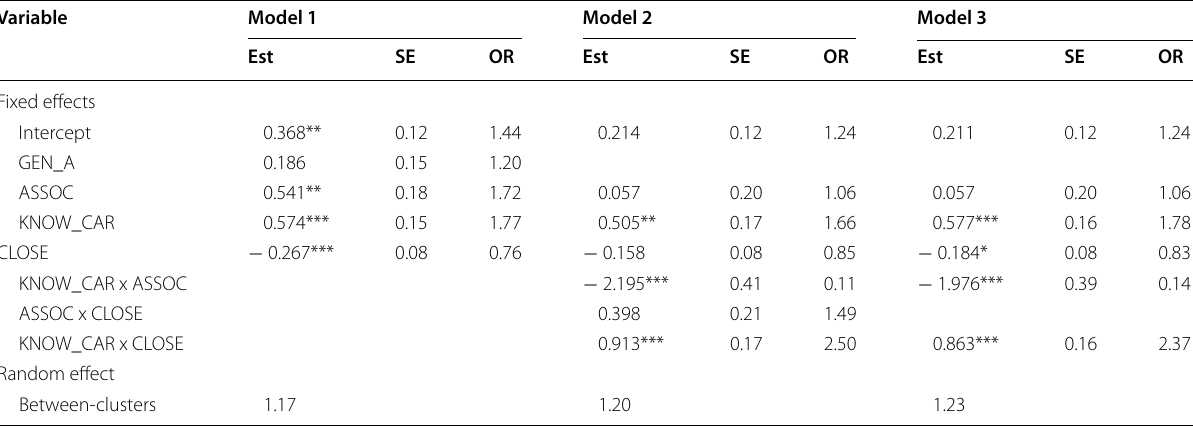
Note. Est coefficient =